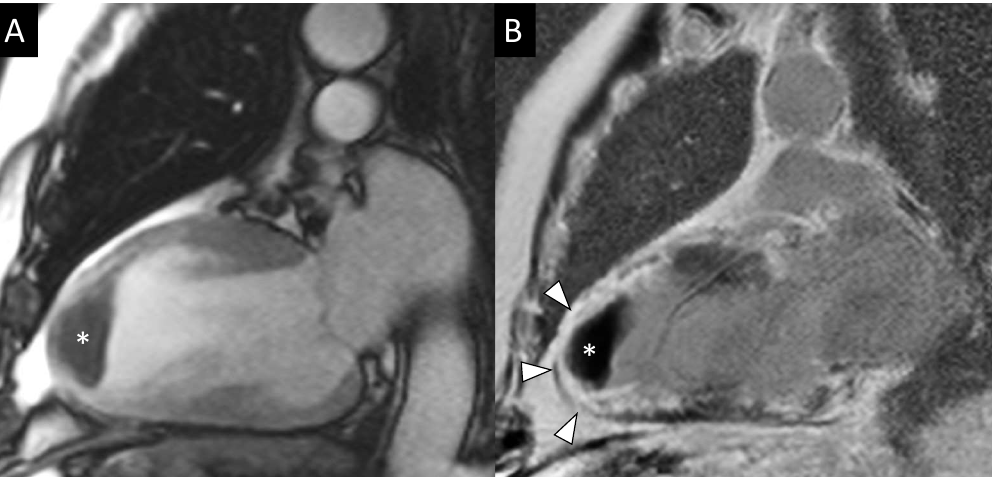
Figure 1. Apical post-infarction aneurysm and intracavitary thrombus. The cine-MR image acquired on the vertical long-axis view ( A ) showed aneurysmal remodeling of the apex with a homogenous hypointense thrombus adhered to the wall (*, size of 4 × 2.5 cm). On the LGE image ( B ), the mass appeared markedly hypointense compared to the ventricular blood pool and was surrounded by an enhanced infarcted LV wall (transmural LGE pattern, arrowheads).